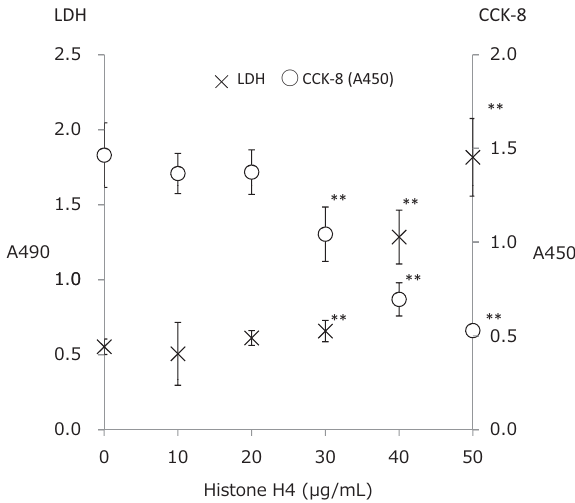
Fig. 1 Cell viability and cellular injury after treatment with histone H4. Vascular endothelial cell viability was measured based on the CCK- 8 level, while cell injury was represented by the lactate